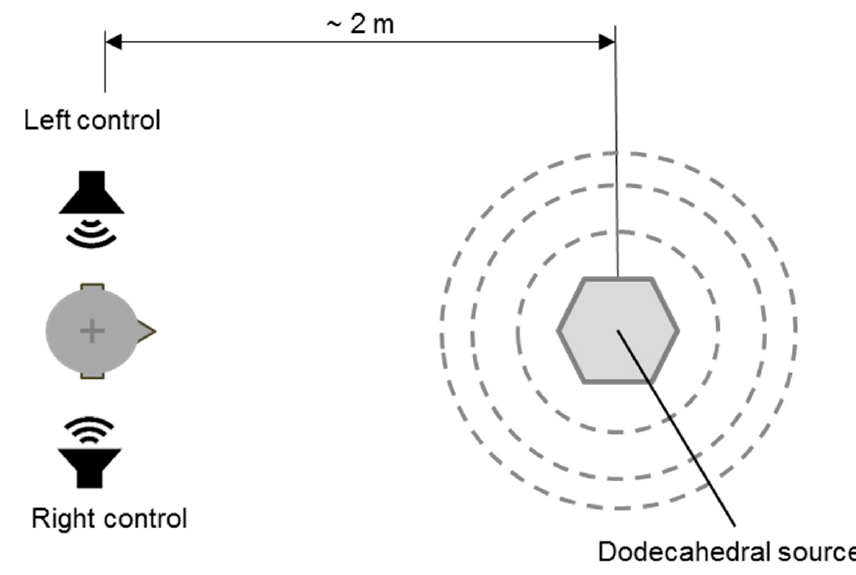
Figure 5. Schematic of the ANC experimental set-up.